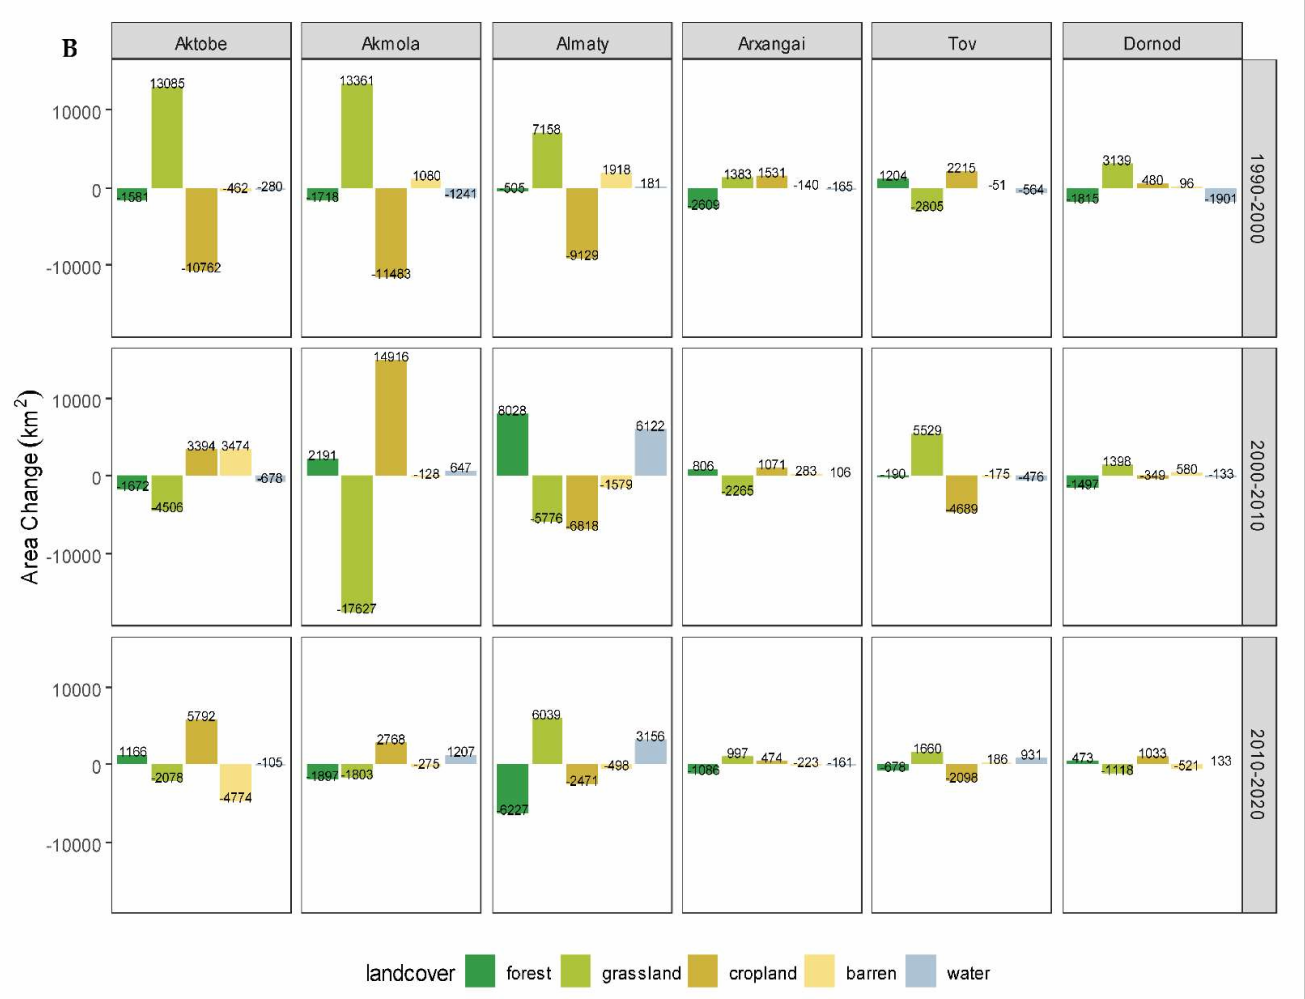
Figure 2. Decadal changes of land cover for the six provinces in Kazakhstan and Mongolia during 1990–2020. ( A ) Land cover change in proportion of the provincial total; ( B ) land cover change in area (km 2